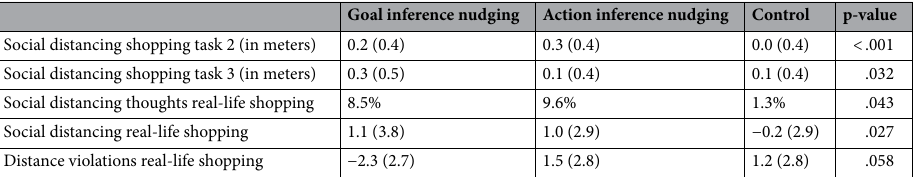
Goal inference nudging Action inference nudging